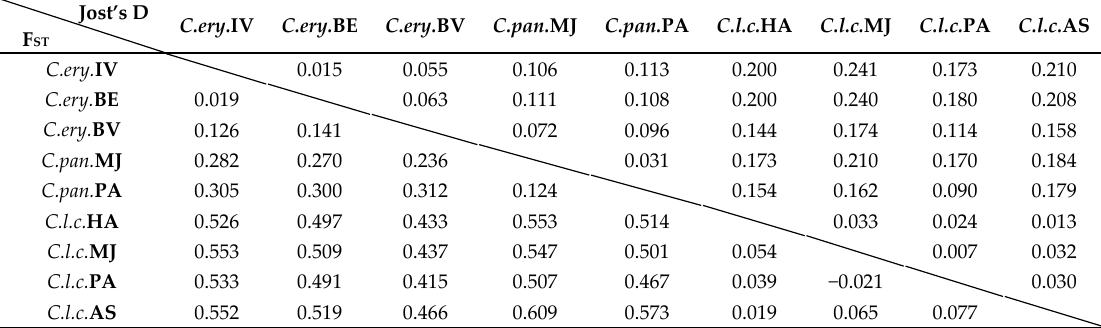
Table 2. Estimated genetic di ff erentiation of populations based on F ST and Jost’s D